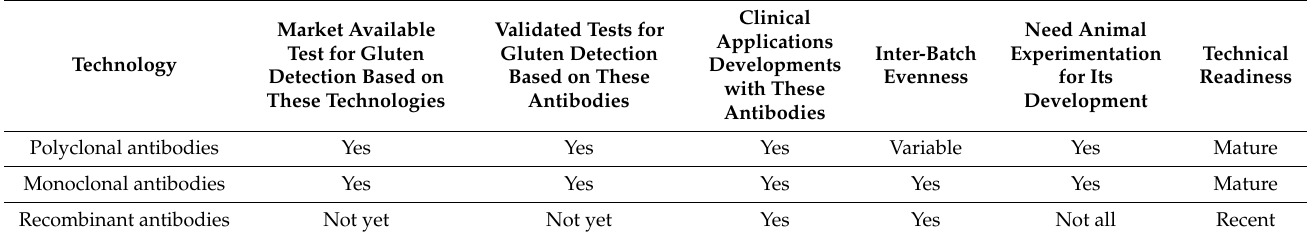
Table 6. Comparison of technologies available for production of antibodies for gluten detection in foods.